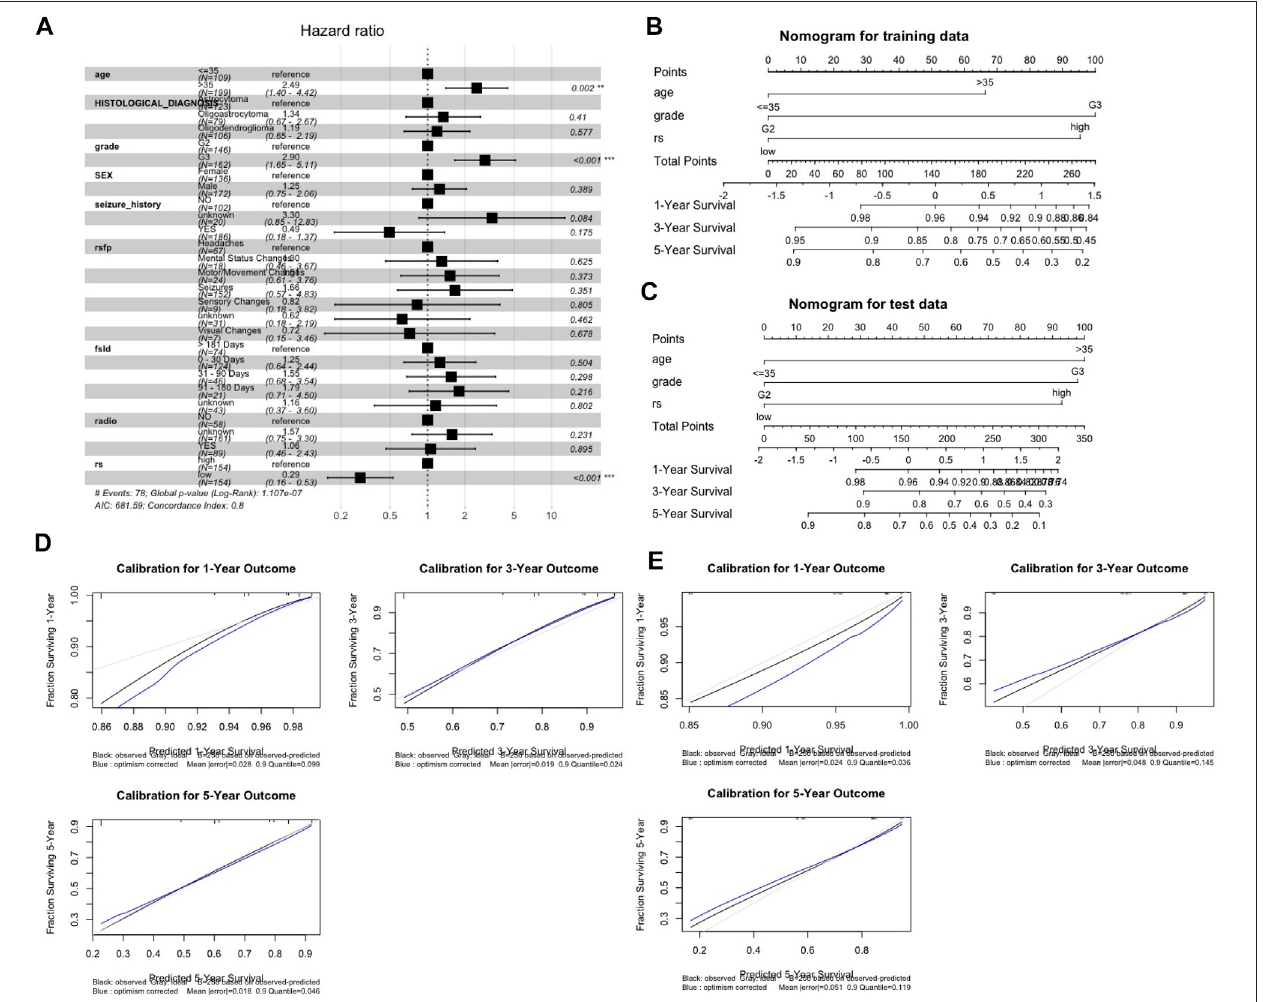
FIGURE 3 | Nomogram development and validation. (A) Forest plot for identi fi cation of risk covariates. (B,C) One-, three-, fi ve-year nomogram plots on the trainning set (B) and the test set (C) . (D,E) Evaluation of nomograms using calibration curves on the training set (D) and the test set (E) . Abbreviation: rsfp, First presenting symptom; fsld, First presenting symptom longest duration; radio, radiation therapy; rs, m6ALncSig risk